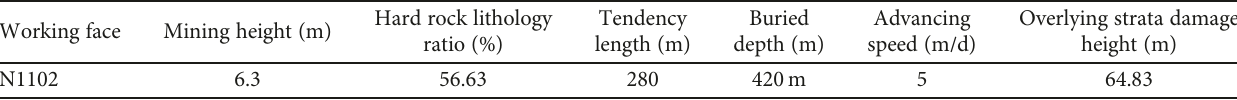
Table 7: In fl uence parameter list of overlying stratum failure height in N1102 working face.